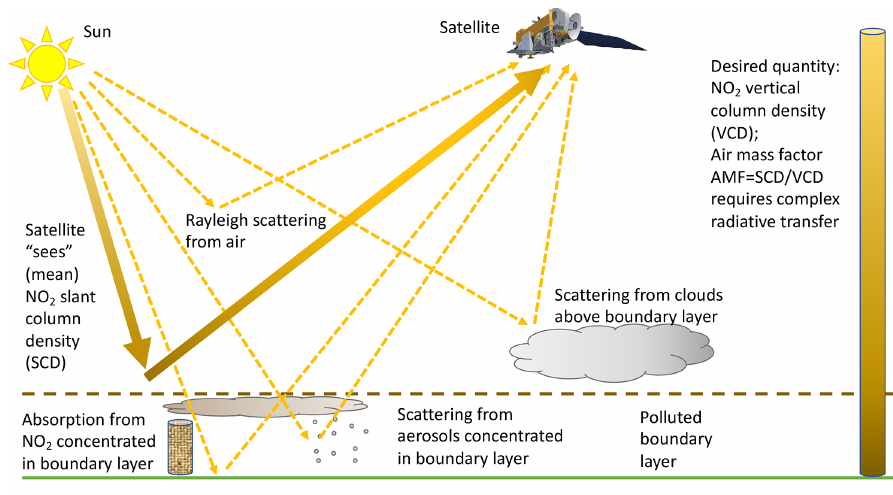
Figure 1. Conceptual diagram showing various paths of scattered and/or absorbed sunlight relevant to an NO 2 retrieval that may be observed from satellite along with standard terminology used for UV–vis trace-gas retrievals.